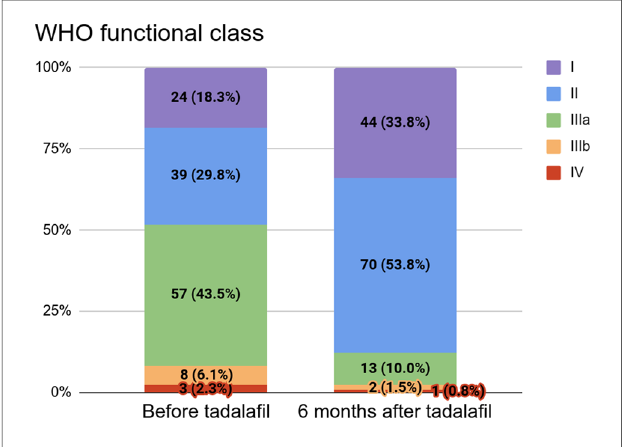
FIGURE 2 WHO functional class before ( n =131) and six months after ( n =130) tadala fi l initiation.